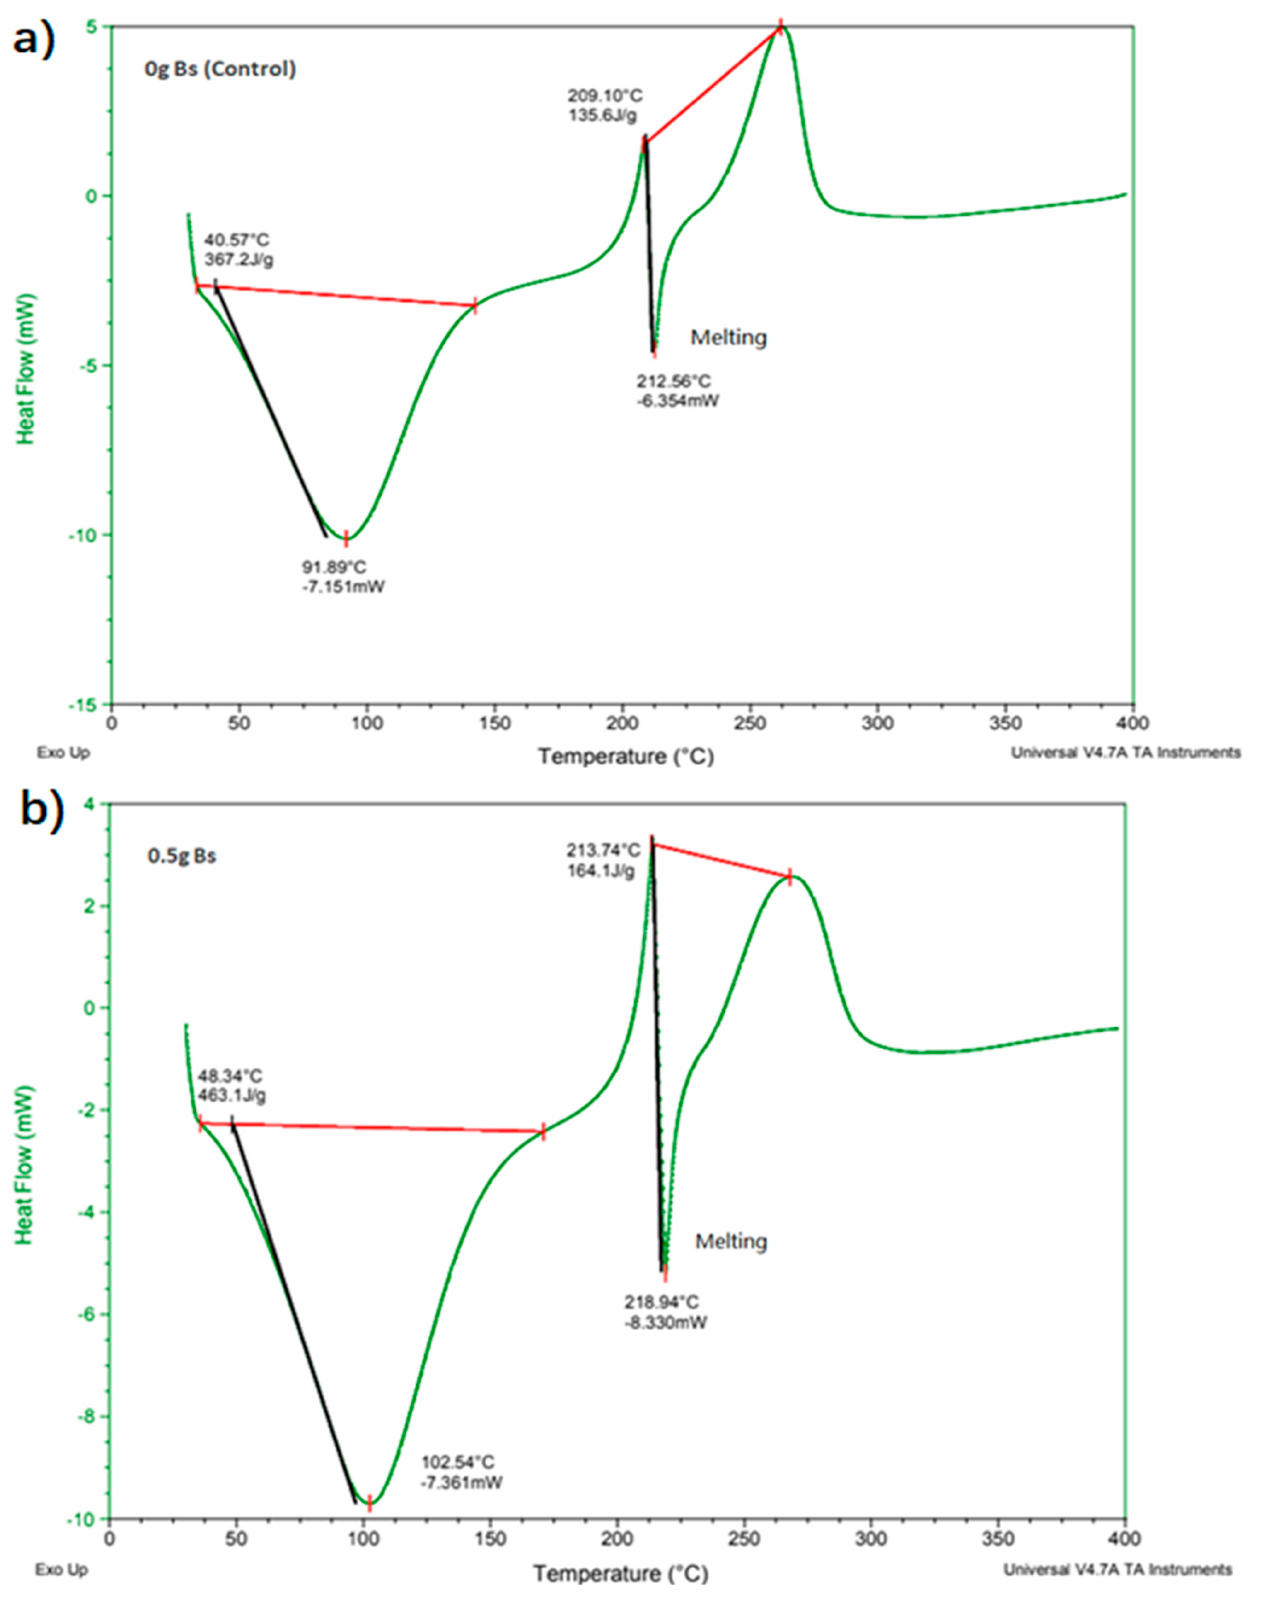
Figure 8. Differential scanning calorimetry (DSC) graph of ( a ) sodium alginate film and ( b ) 0.5 g microbial composite film.